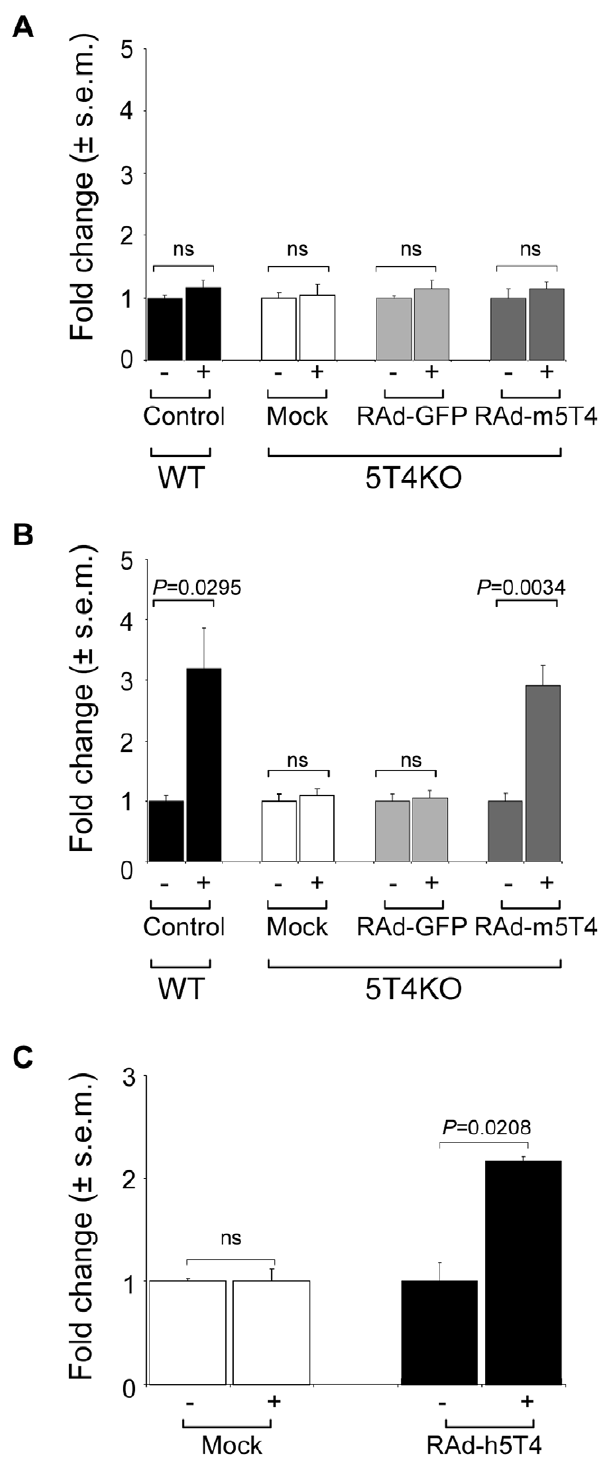
Figure 2. 5T4 restores CXCL12 dependent chemotaxis in differentiating 5T4KO-ES cells. (A). Undifferentiated 5T4KO-ES cells forced to express 5T4 following infection with RAd-m5T4, (multiplicity of infection =30, dark grey columns) show no CXCL12 dependent chemotaxis comparable to undifferentiated WT-ES cells (black columns), mock (white columns), or RAd-eGFP (light grey columns) infection. (B), Differentiating 5T4KO ES cells with 5T4 expression restored by RAd-m5T4, (multiplicity of infection =30, dark grey columns) show CXCL12 chemotaxis comparable to differentiating WT-ES cells (black